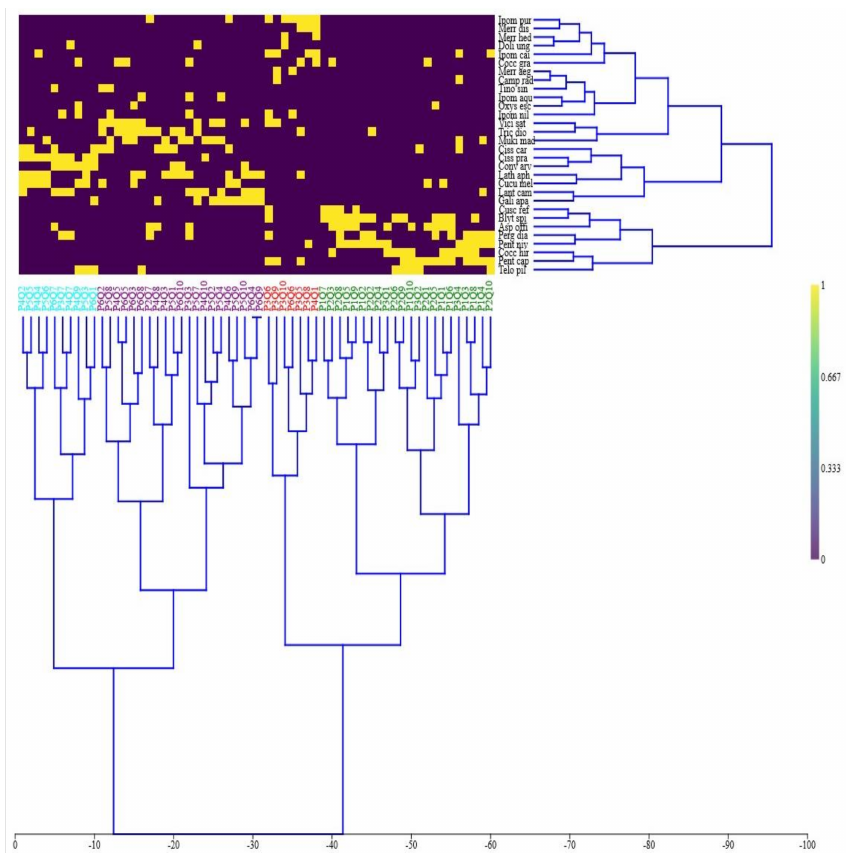
Figure 4. Two-way cluster dendrogram exhibiting the distribution of 30 species and 60 sample plots. The blue color represents absence, while the yellow color indicates the presence of species. The right side of the figure shows the species. The sampling plots of group 1 are highlighted with aqua color, group 2 with purple color, group 3 with red color, and group 4 with green